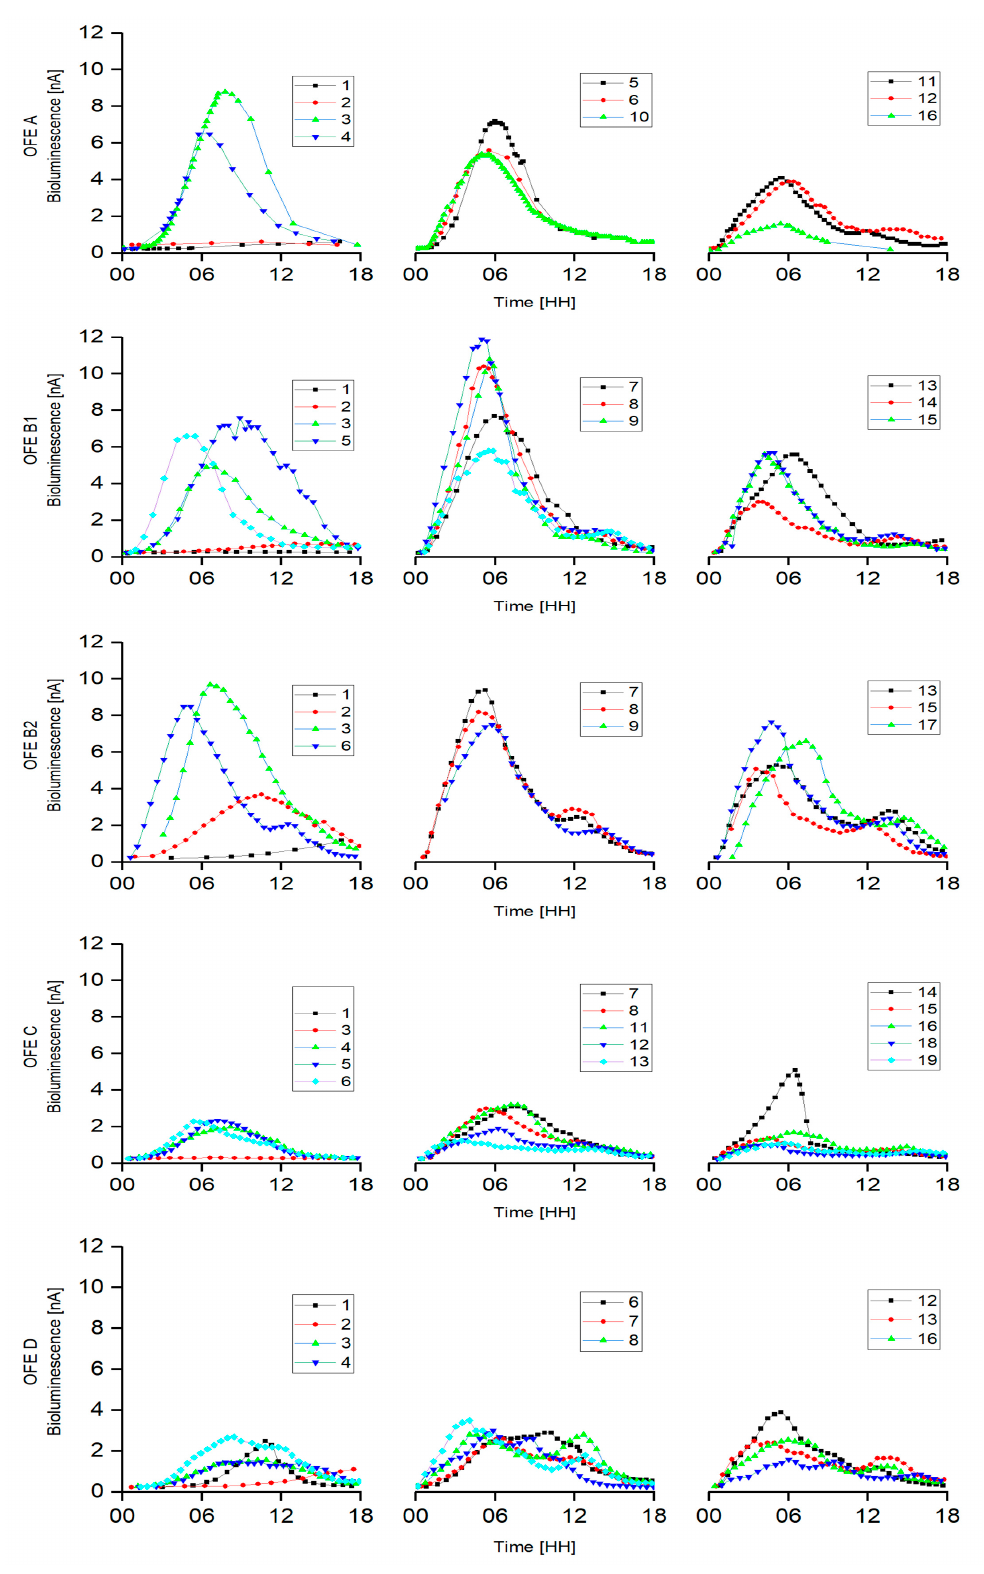
Figure 5. Time-records of daily inductions of bioluminescence of P. putida TVA8 immobilized on each of the five available OFEs (A, B1, B2, C, D). Background noise of 26 nA was subtracted from the measured data. Y -axis denotes detected bioluminescence intensity in nA. X -axis denotes time from the induction of bioluminescence in hours. Each experiment lasted 15–19 days. Chart legends denote the measurement day number.